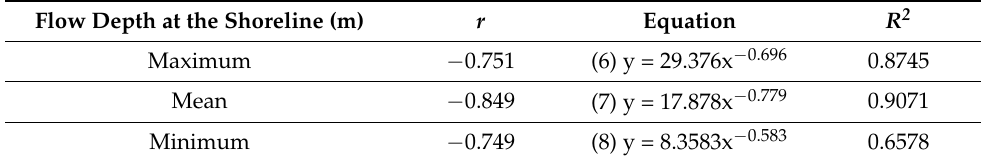
Figure 8. ( a ) Plot of WDPP against ShpP (x-axis in logarithmic scale, base 2), and related equations, coefficient of determina- tion (R 2 ), and correlation coefficient ( r ). Data size and color relate to maximum lake depth. The blue circle refers to the 2007 Chehalis Lake landslide-generated wave case, used as a test of the proposed approach (Section 7). The r -values with red font, which are not shown in Figure 6, correspond only to the red dots. ( b ) Linear regression plot obtained for the relation between ShpP and WDPP (the resulting equation is the same as the one obtained with the trendline in Figure 8a). Table 3. Relationships between WDPP and flow depths at the shoreline, including correlation coefficients ( r ) , equations, and coefficients of determination ( R 2 ). In the equations, y is flow depth and x is WDPP obtained from the equations in Table